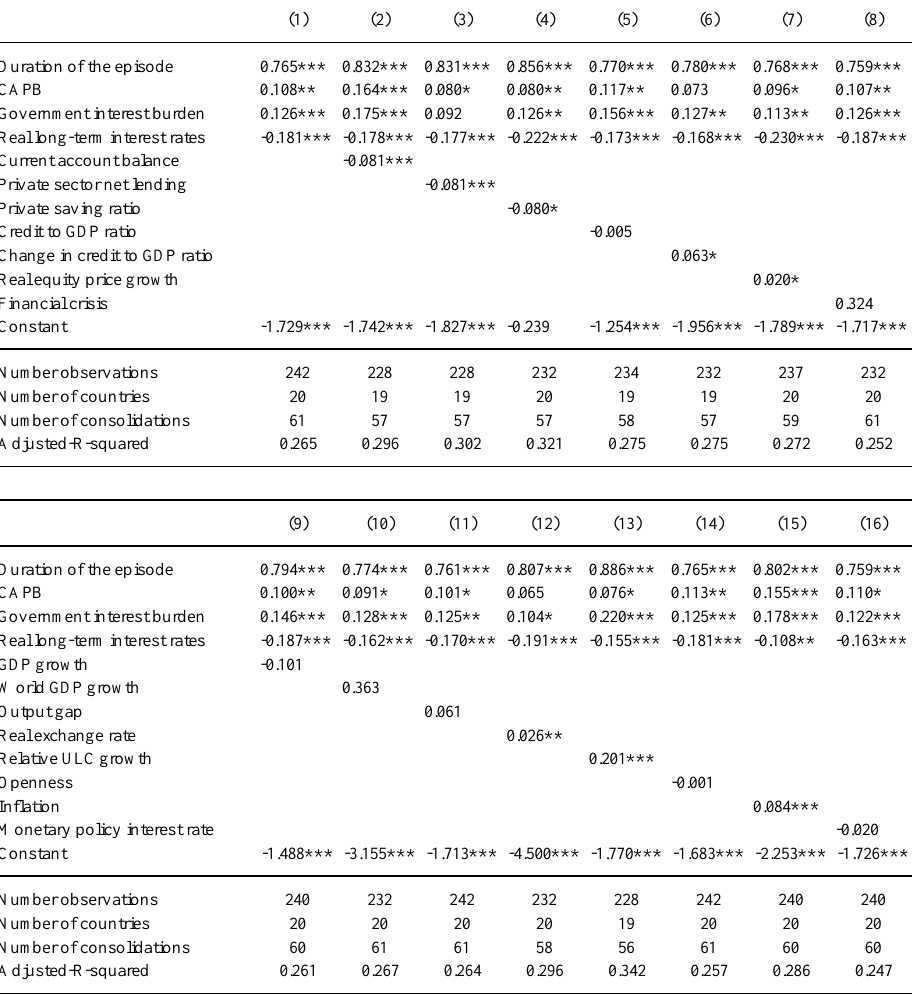
Table 5: Determinants of duration of consolidations – the role of macroeconomic conditions (estimates of hazard function using Weibull model, coefficients shown as hazard